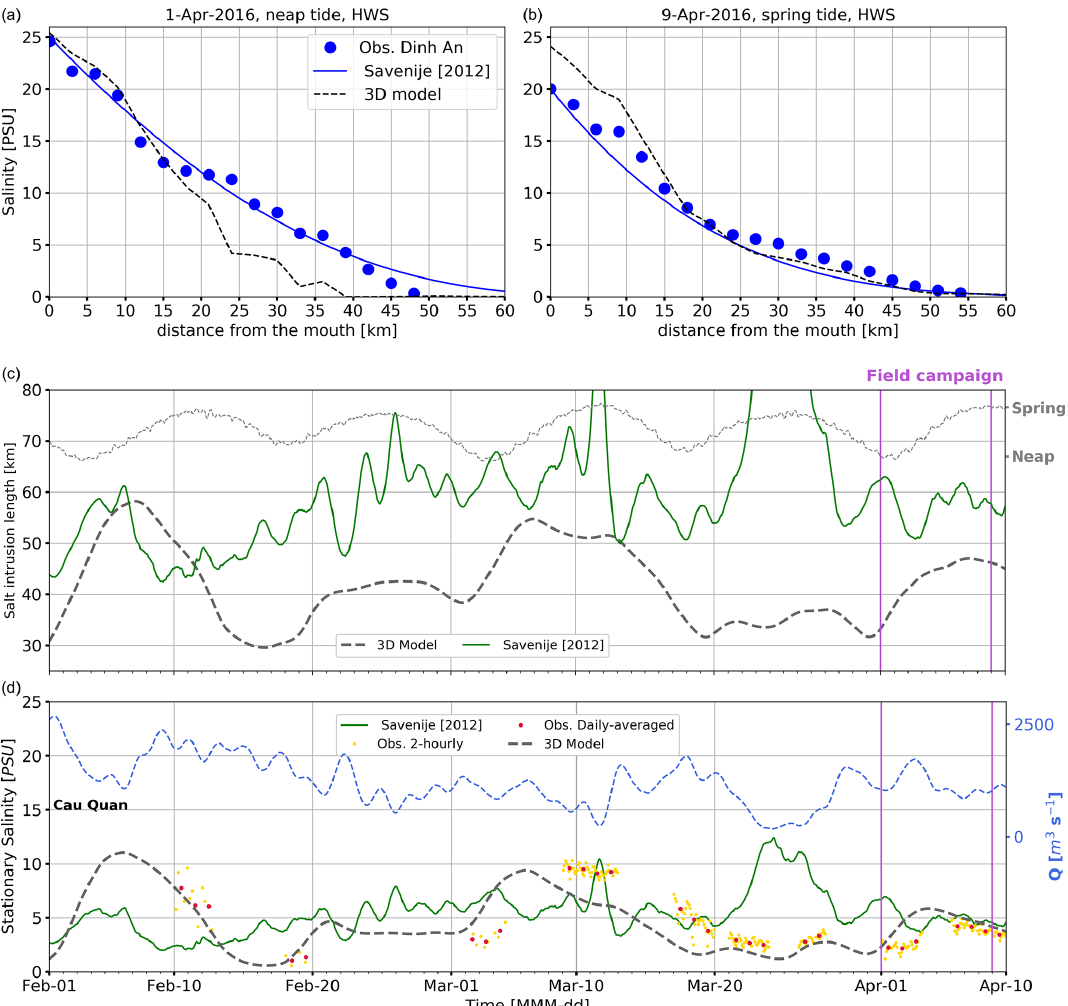
Figure 12. (a, b) Observed vs. numerically (3D) and analytically (Savenije, 2012) modelled depth-averaged along-channel salinity at high water slack (HWS) along the Dinh An channel. (c) Comparison of the numerical (3D) vs. analytical (Savenije, 2012) tidally averaged SWI length along the Dinh An channel. (d) Observed vs. numerically (3D) and analytically (Savenije, 2012) modelled salinity at Cau Quan station nearly 27km from the sea within the Dinh An